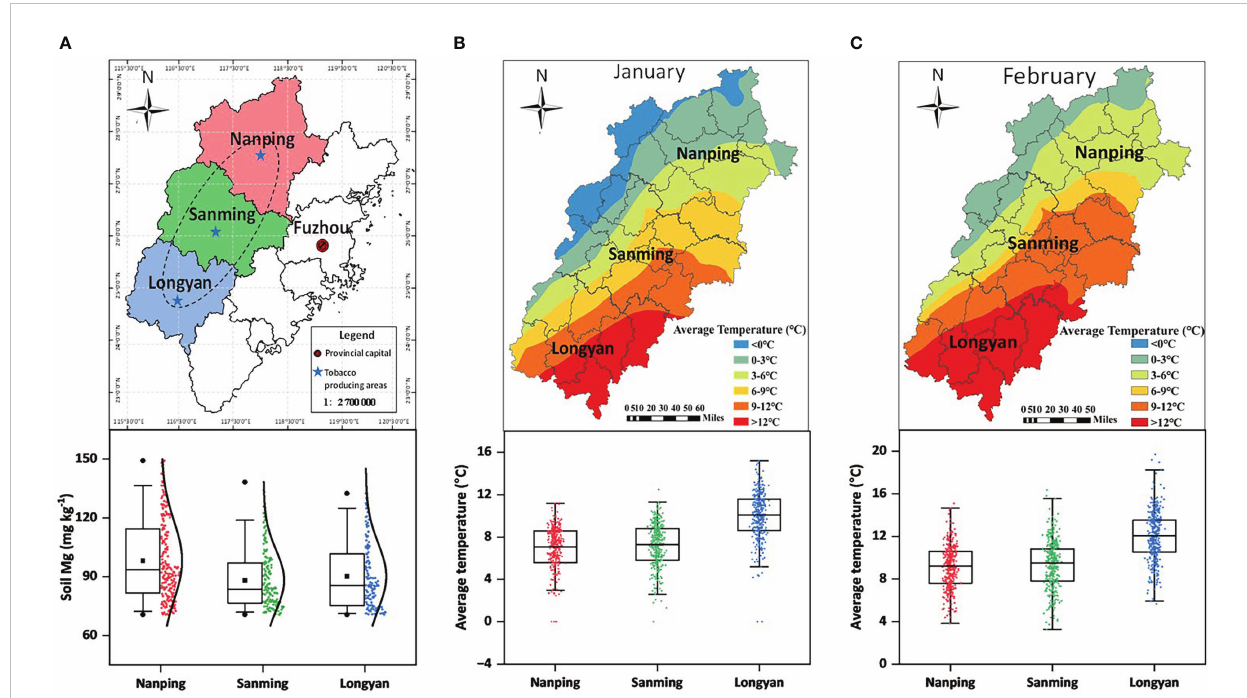
FIGURE 1 Map representing the geographic distribution of tobacco. (A) major fl ue-cured tobacco producing areas; (B, C) average temperature during the months of January and